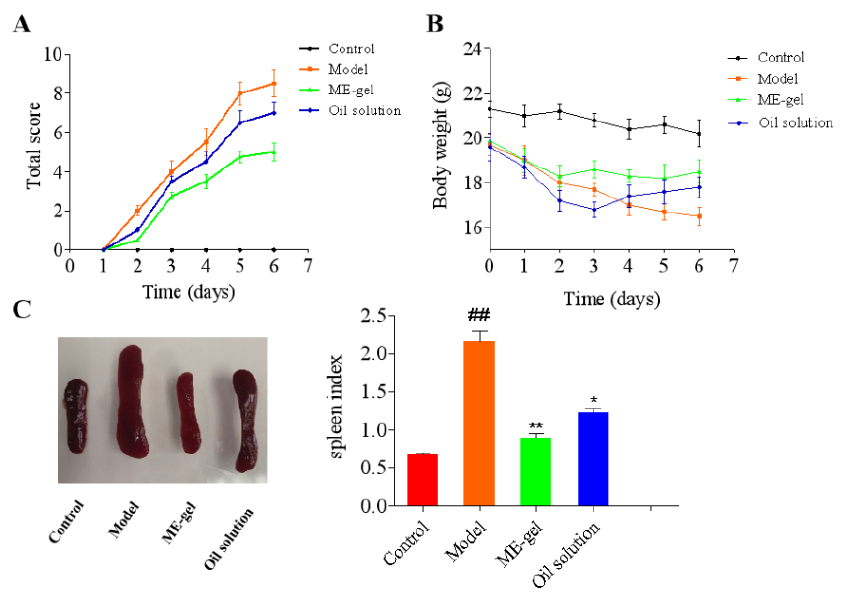
Figure 7. The therapeutic effect of IR. ( A ) PASI score of indirubin on the back skin of IMQ-induced mice. ( B ) Effects of IR on body weight change of IMQ-induced mice. ( C ) Effects of IR on spleen index of IMQ-induced mice. The results were expressed as the mean ± SEM. The comparisons between groups were performed using one-way ANOVA (Tukey’s multiple comparisons test). * p < 0.05 and ** p < 0.01 vs. Model; ## p < 0.01 vs. Control ( n = 6).